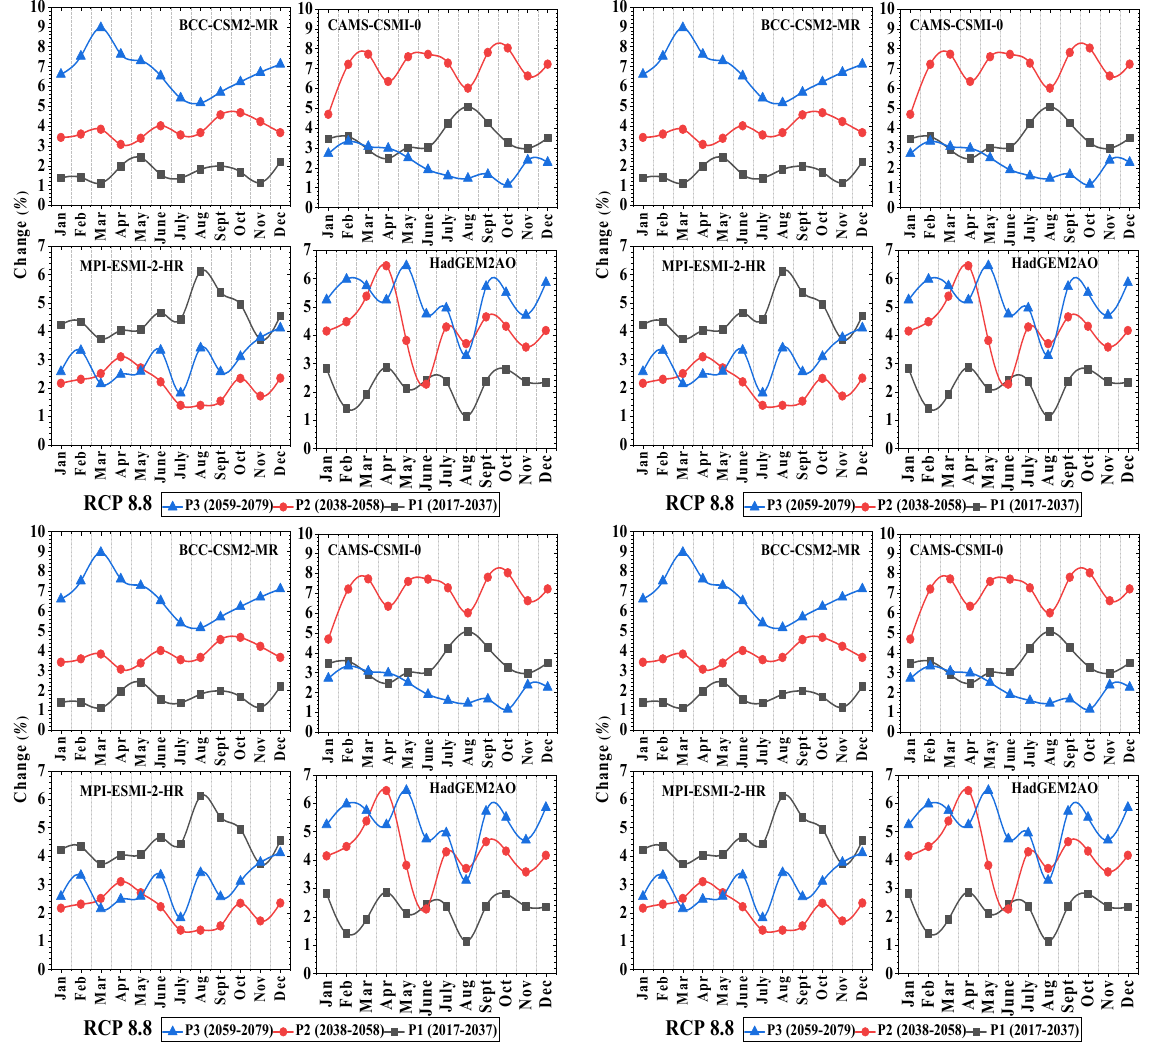
Figure 7. Projected climatology of changes in temperature under AR5-based emission scenarios.